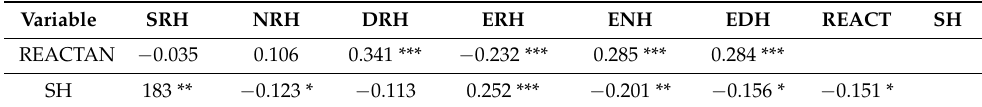
Table 6. Correlations between types of internal and external regulation, psychological reactance and health ( n =